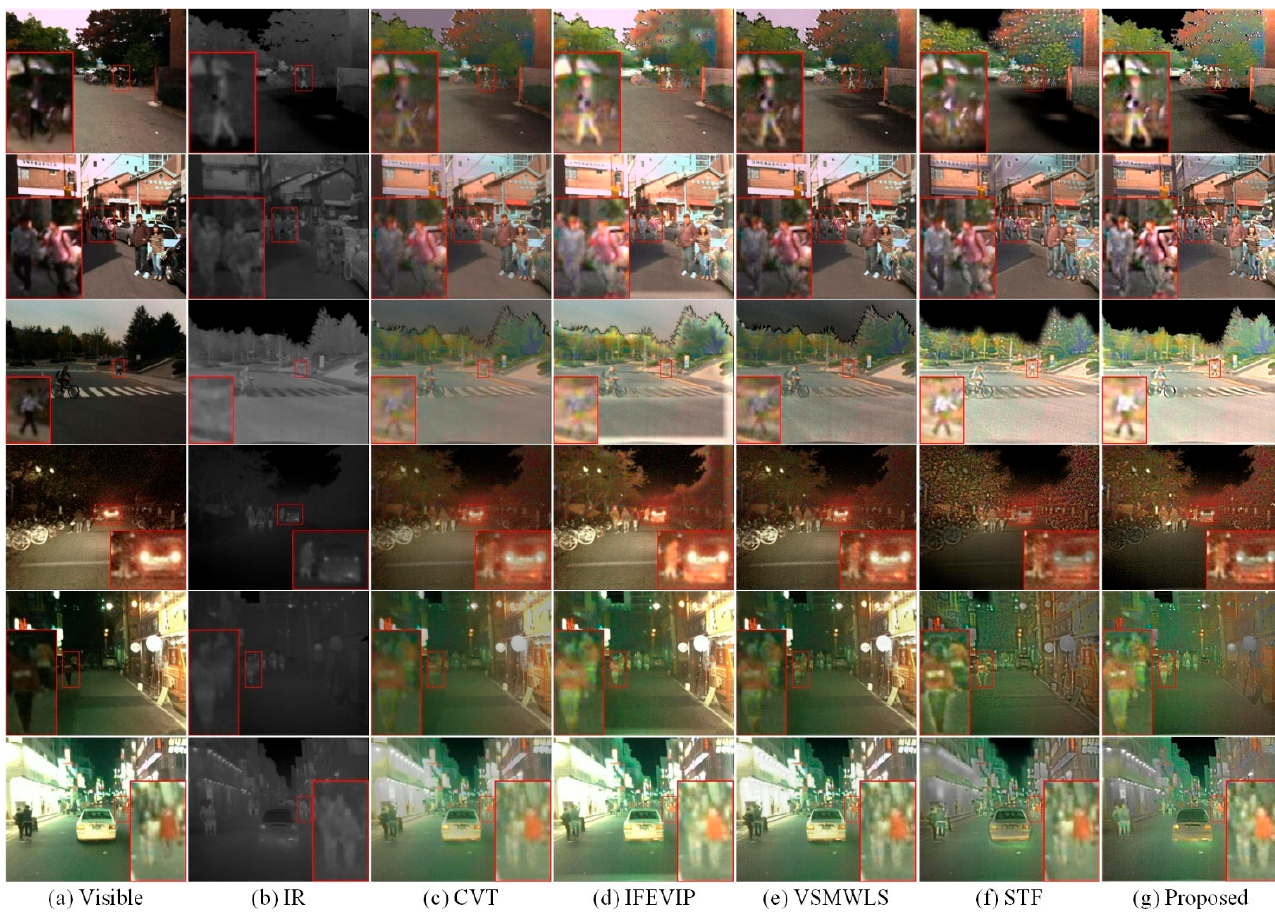
Figure 6. Qualitive comparison of fusion results with different methods. ( a ) shows the visible images; ( b ) shows the infrared images; ( c – g ) respectively show the fusion results based on CVT, IFEVIP, VSMWLS, STF and the proposed method.